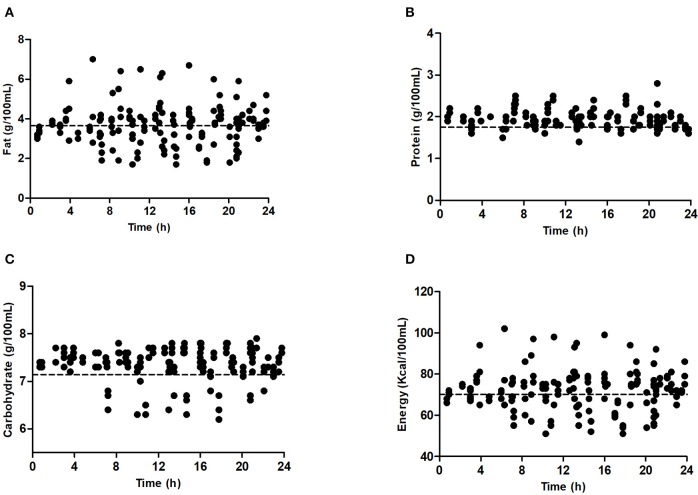
Nutrients in milk sample on day 7. (A) Fat; (B) protein; (C) carbohydrate; (D) energy.